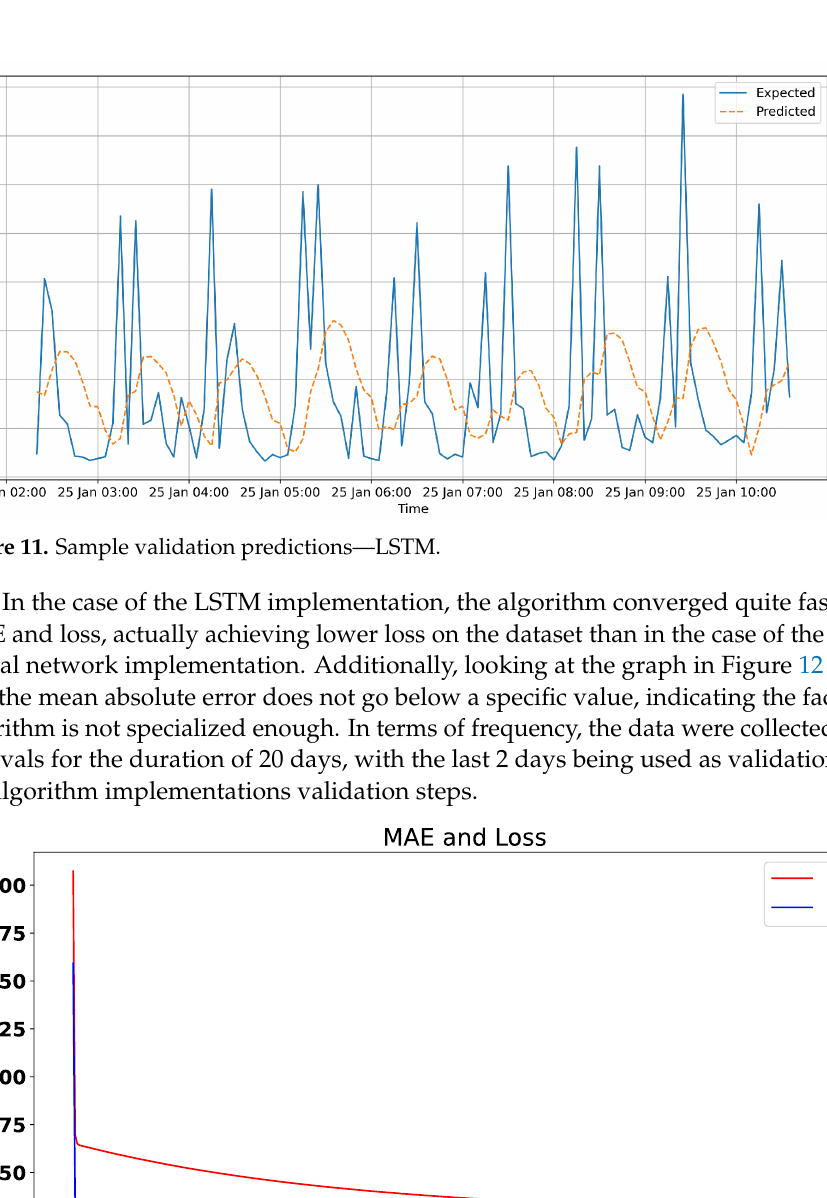
Figure 12. MAE and loss—LSTM training